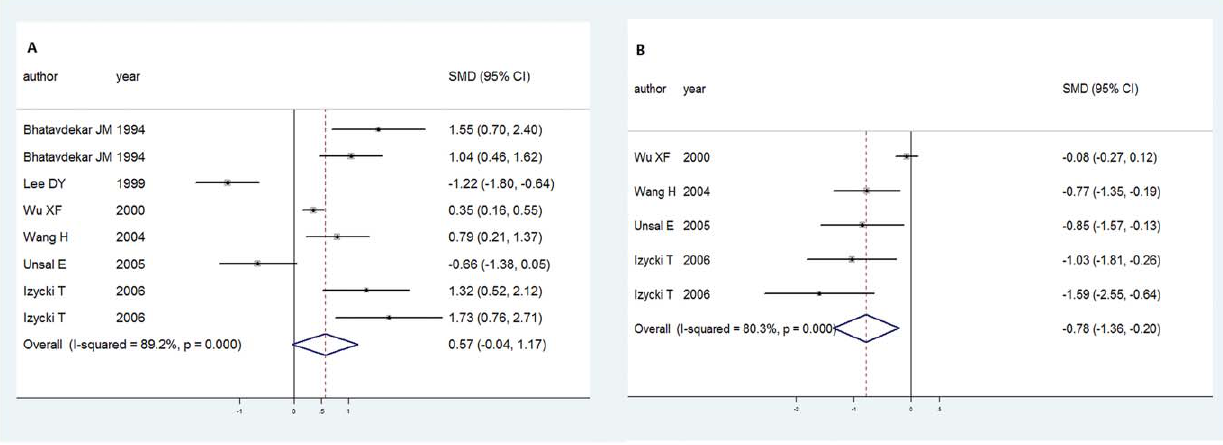
Figure 3. Forest plot of cancer risk associated with the IGF-1 and IGFBP-3 in case-control studies. A. Standard mean differences with corresponding 95% CIs of the circulating IGF-1 level of individual studies and pooled data of the case-control studies. B. Standard mean differences with corresponding 95% CIs of the circulating IGFBP-3 level of individual studies and pooled data of the case-control studies.